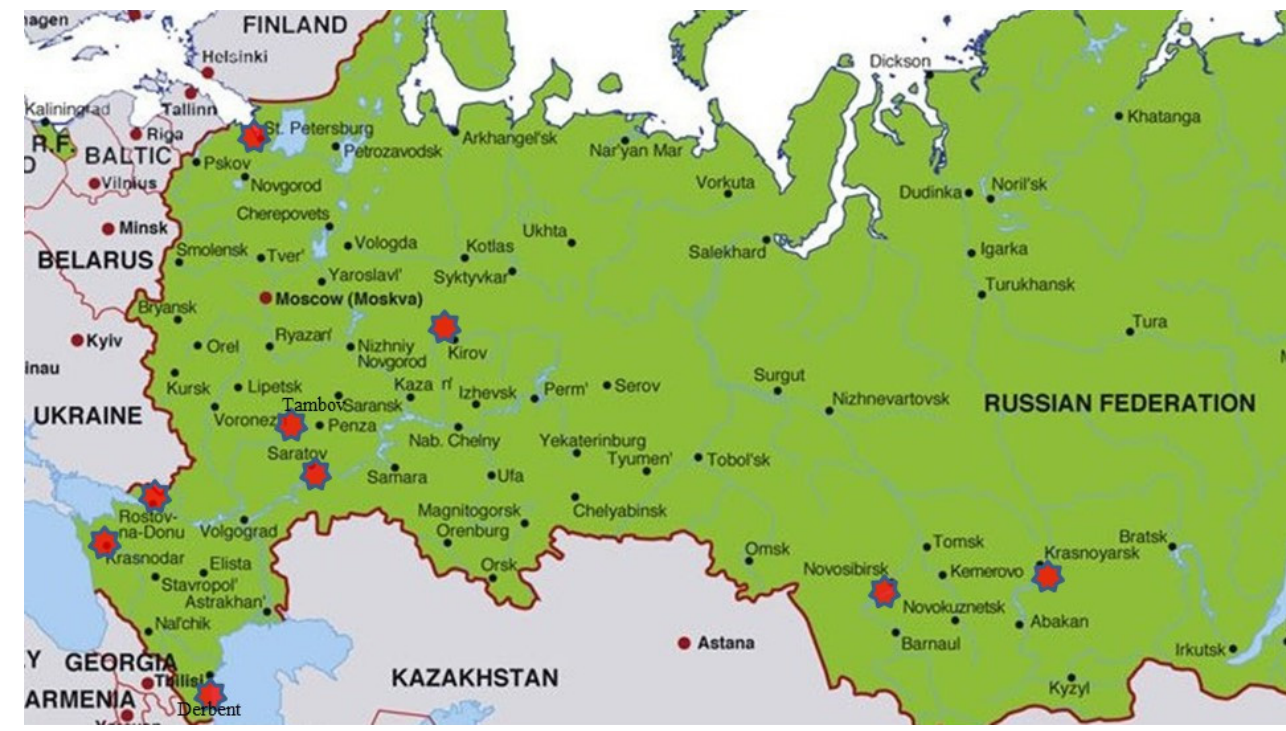
Figure 1. Collection sites of Puccinia striiformis in Russia. Table 1. Sampling and isolation details for collections of Puccinia striiformis in regions of Russia.